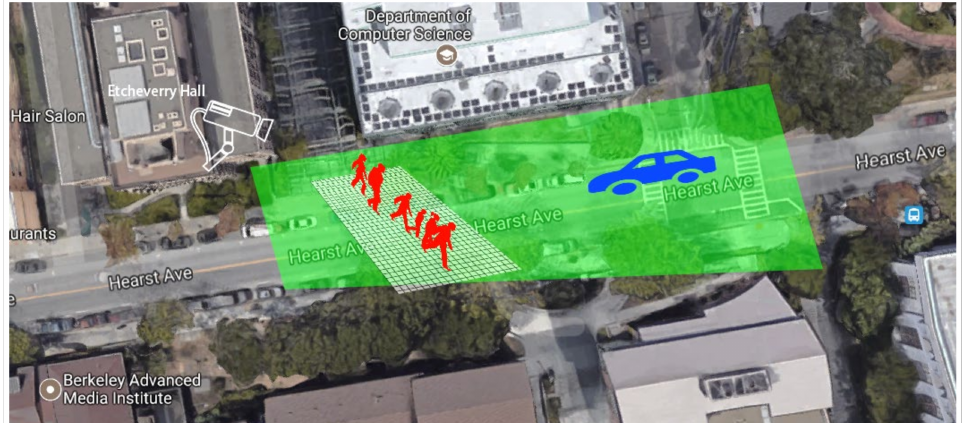
Figure 3. Satellite view of the experimental area. The installation position of the camera is indicated in the figure. The green area represents the camera field of view. The white speckle area is the selected area of the target pedestrian, and the target pedestrians marked in the dataset come from this area.